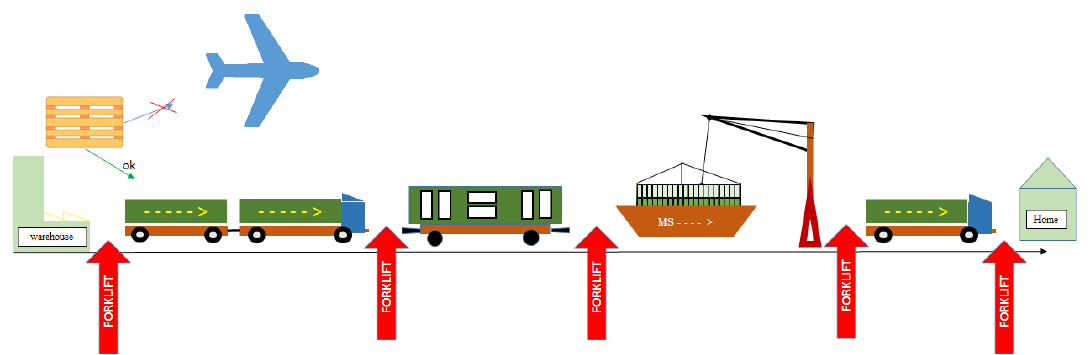
Figure 1. Possible damage to load caused by forklift (red arrow — forklift operating area).